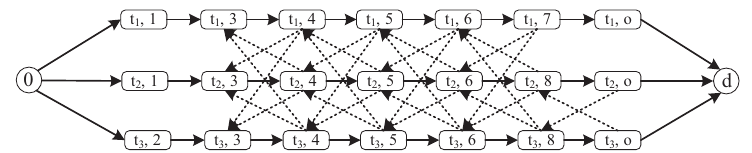
Figure 2. Alternative graph